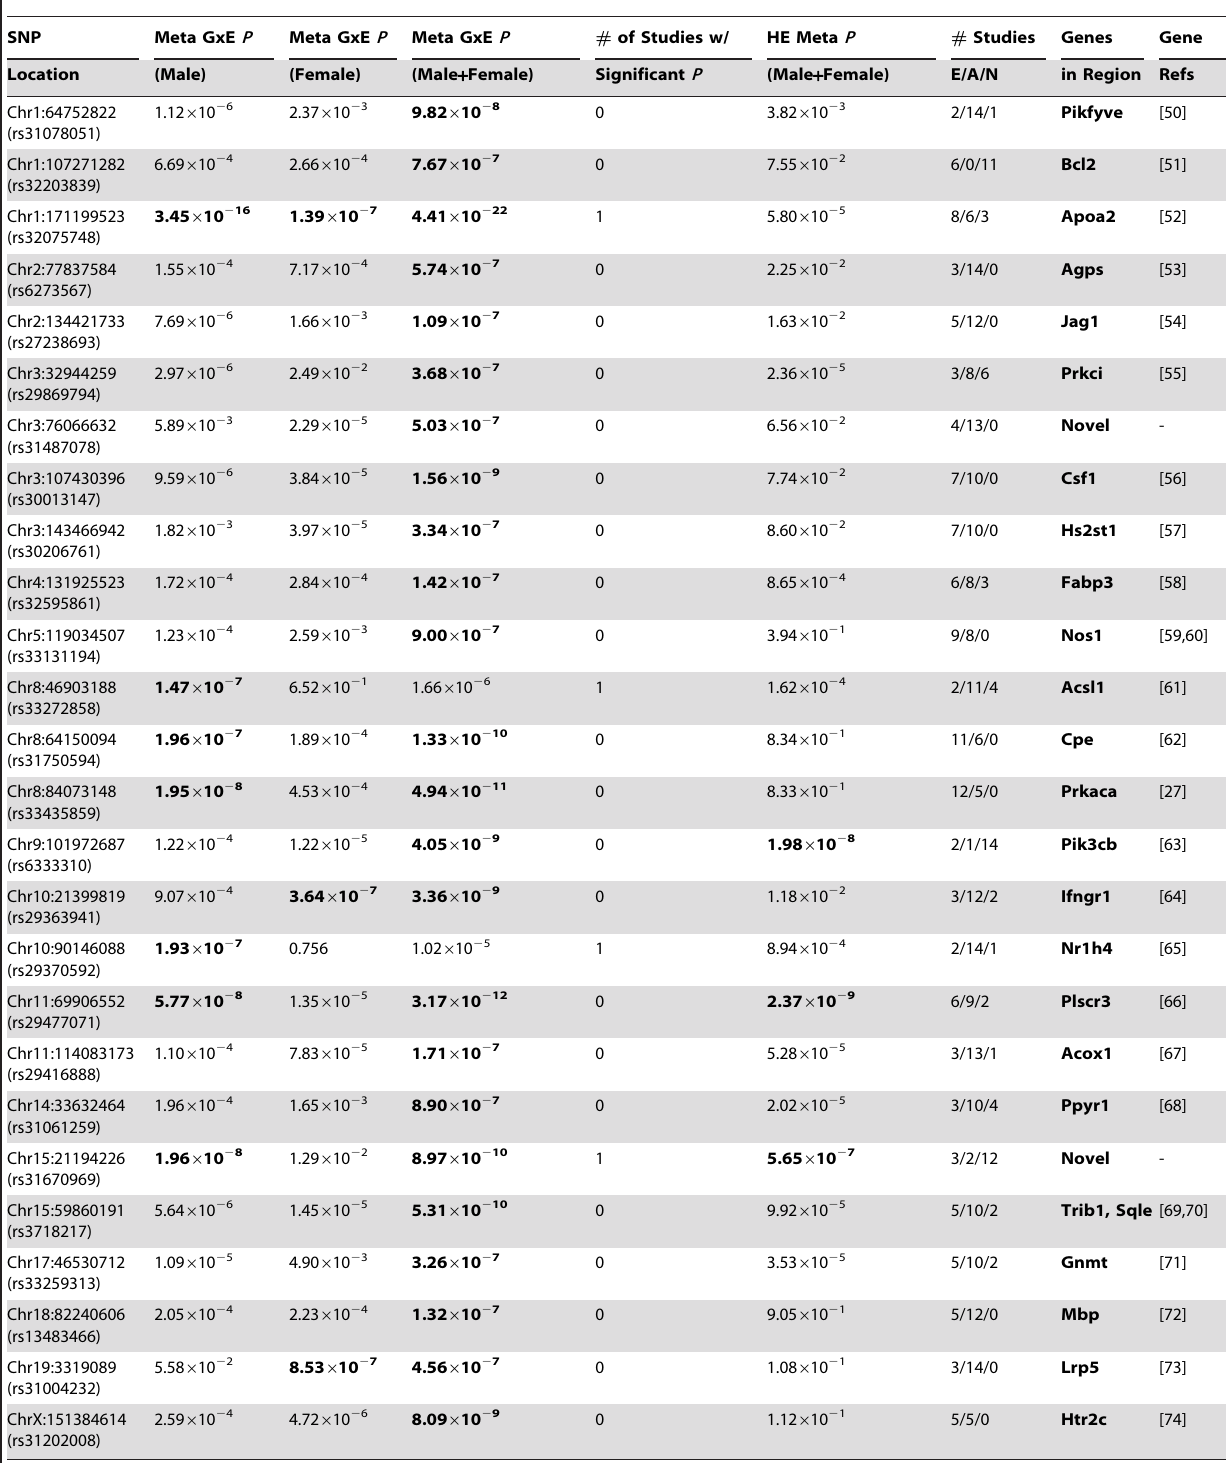
Table 2. 26 significant loci identified by applying Meta-GxE analysis.